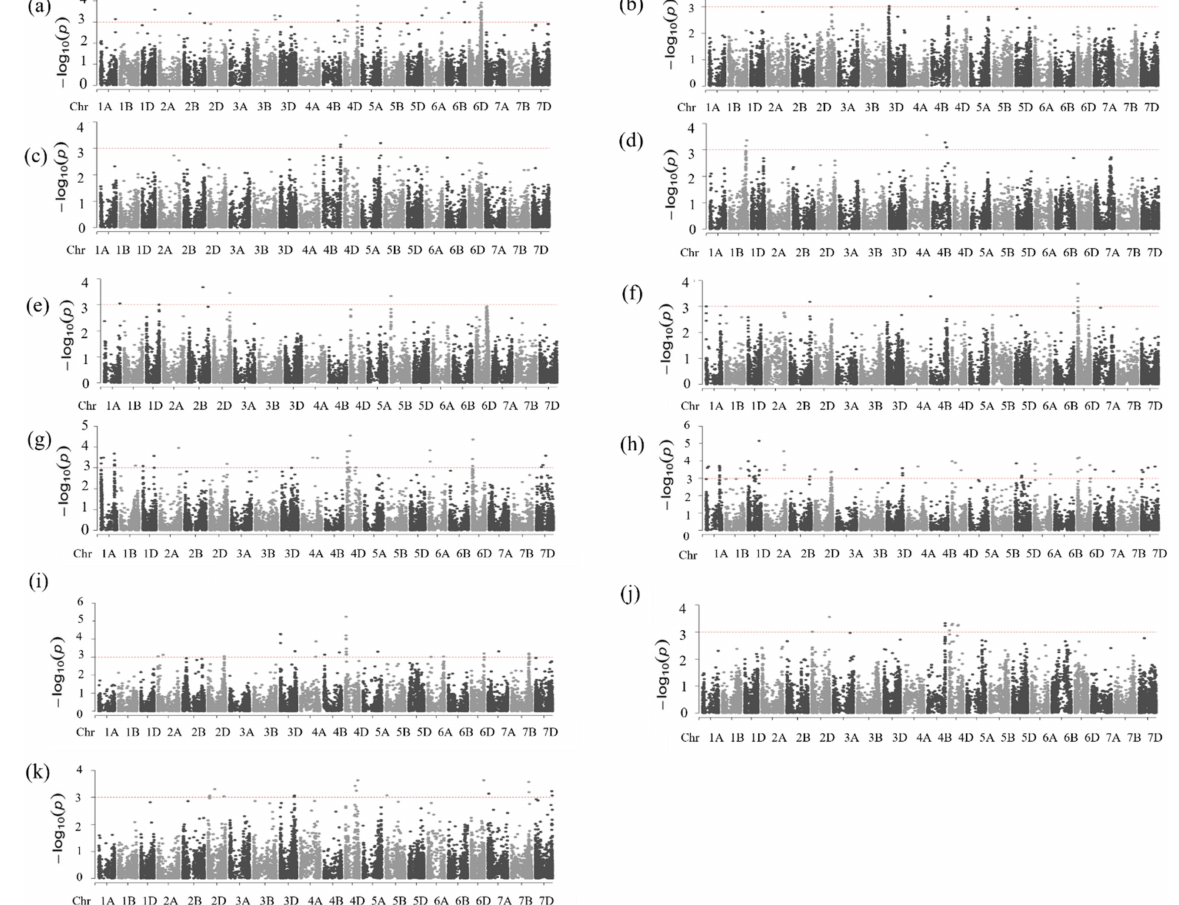
Figure 5. Manhattan plots for protein content ( a – d ) at DON19/29, HUD19/20, MED18/19, and MED19/20, respectively, for dough strength, ( e – h ), at DON19/29, HUD19/20, MED18/19 and MED19/20, respectively, and for grain yield ( i – k ) at DON19/20, MED18/19, and MED19/20,